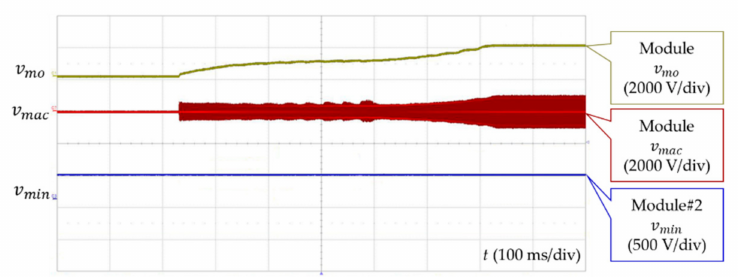
Figure 19. Experimental result of the module voltage